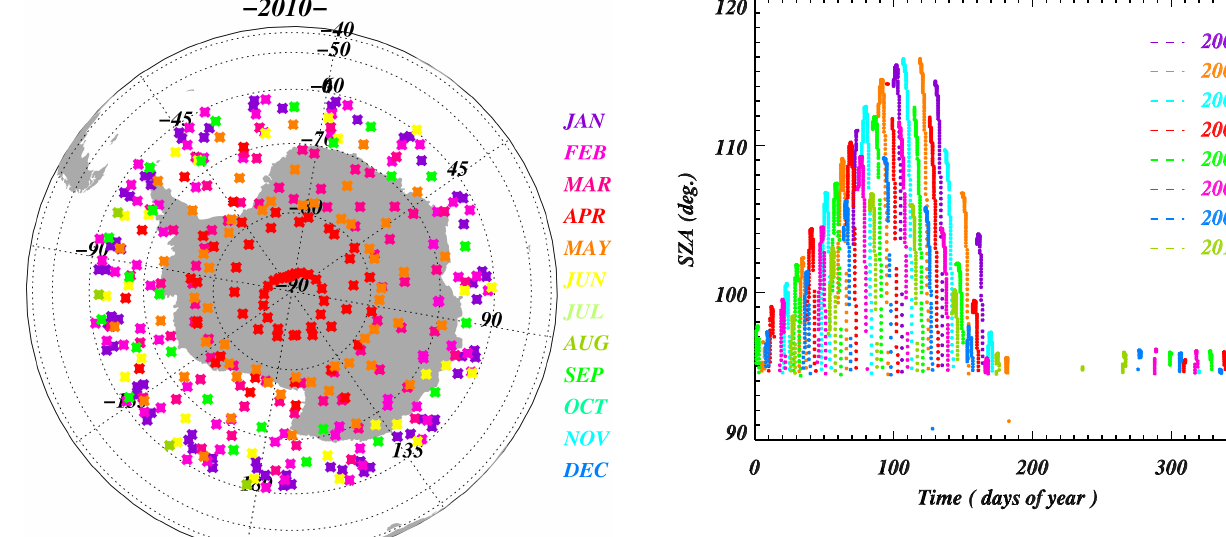
Fig. 3. SCIAMACHY lunar occultation SZA distribution for the years 2003–2010; each year the SZA span is within 94 ◦ and 115 ◦ .